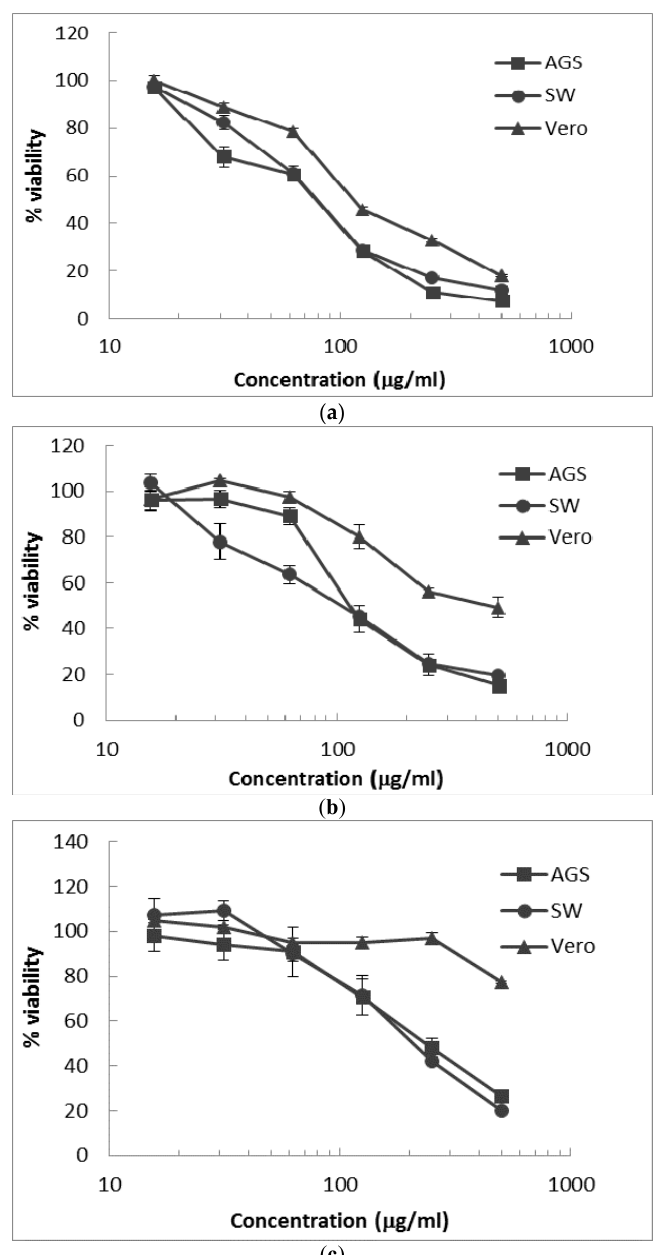
Figure 2. Cytotoxicity dose-response curves of extract treatment on tumoral cell lines. ( a ) Petiveria alliacea , ( b ) P. niruri , ( c ) S. reticulate . Results represent the mean ± SE of triplicates of one representative experiment of each cell line.